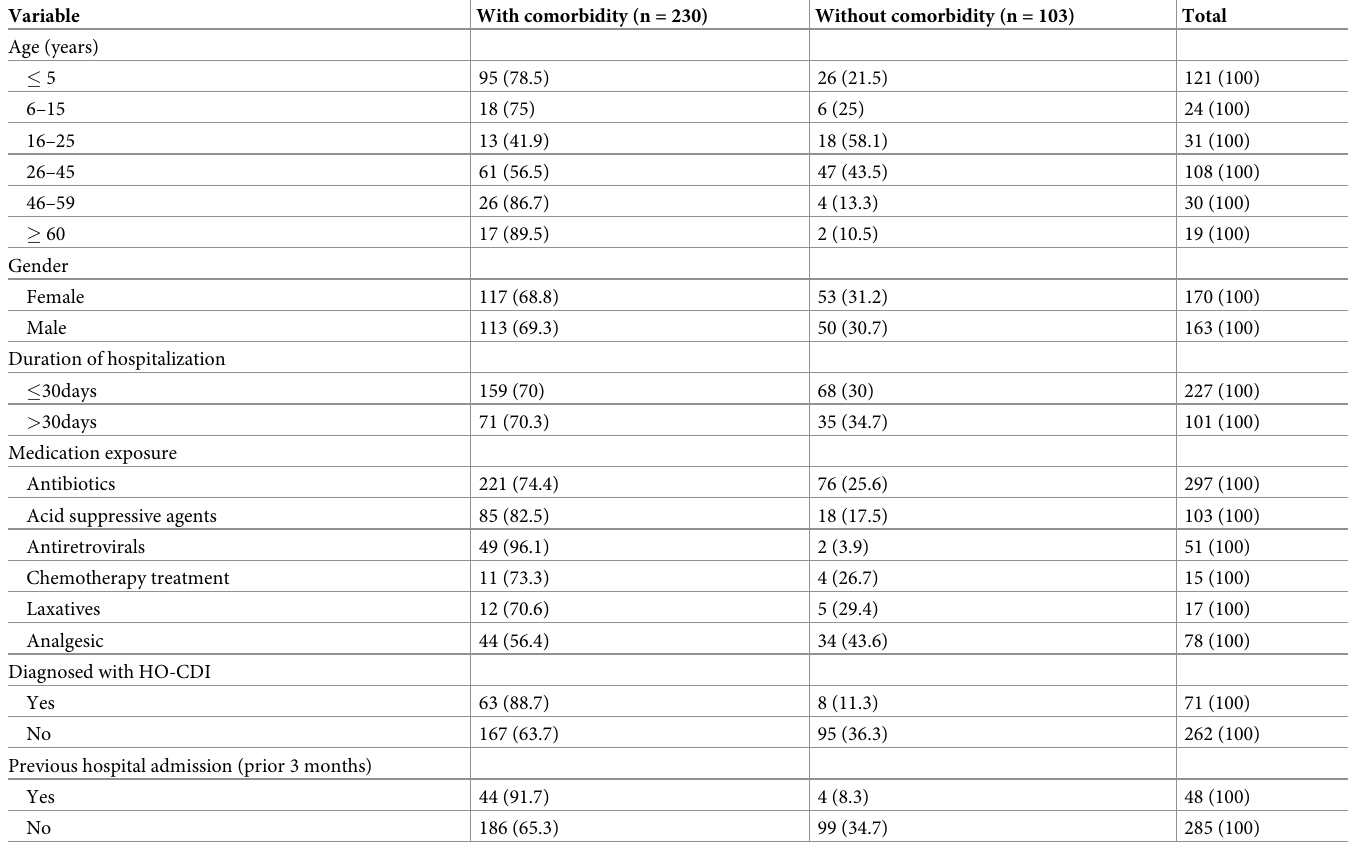
Table 1. Baseline characteristics of the study